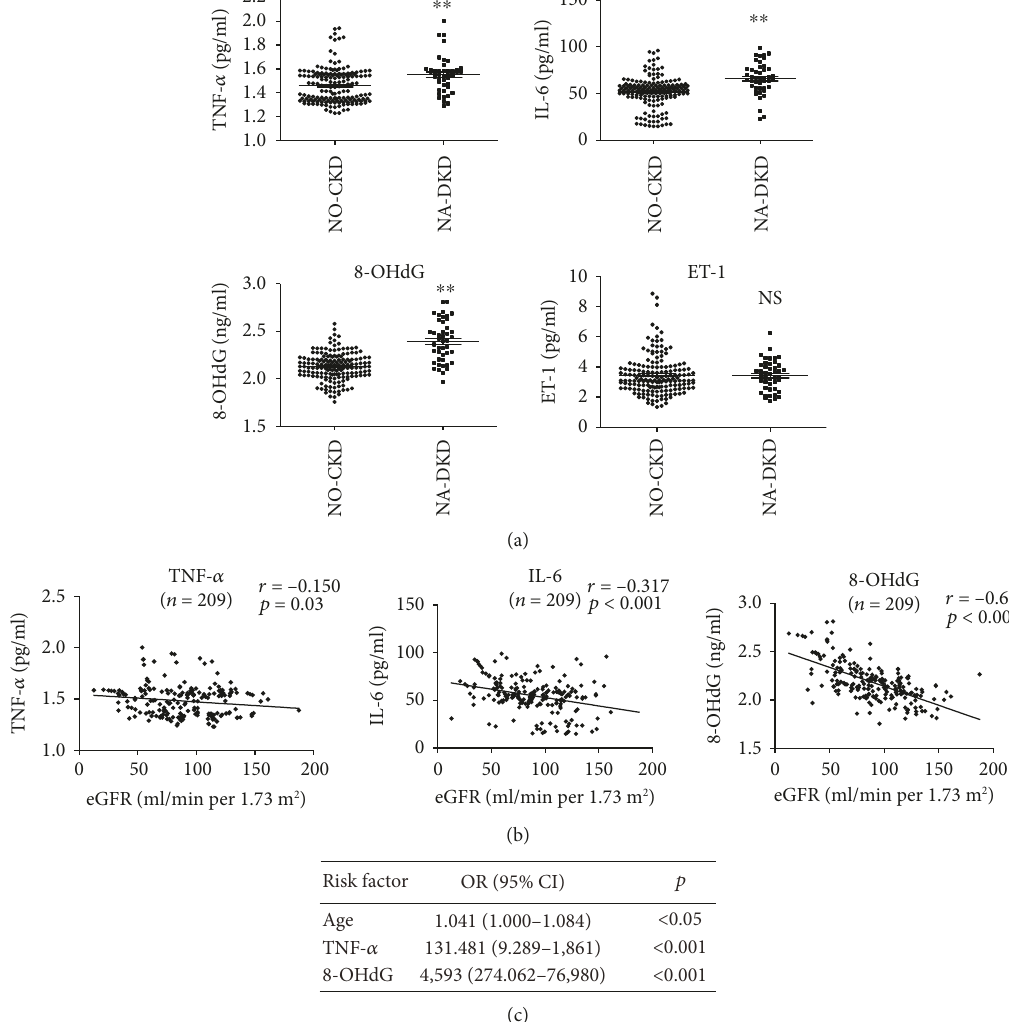
Figure 1: Correlations between plasma TNF- α , IL-6, 8-OHdG, and ET-1 with eGFR in T2DM patients with normoalbuminuria. (a) Di ff erences in the plasma TNF- α , IL-6, 8-OHdG, and ET-1 levels in patients with normoalbuminuria with/without renal insu ffi ciency. (b) Relationships of plasma TNF- α , IL-6, and 8-OHdG with the eGFR in T2DM patients with normoalbuminuria. (c) Logistic regression analyses between clinical parameters, plasma TNF- α , IL-6, and 8-OHdG and eGFR. 8-OHdG: 8-hydroxydeoxyguanosine; ET-1: endothelin-1; NO-CKD: normoalbuminuric T2DM patients without renal insu ffi ciency; NA-DKD: normoalbuminuric T2DM patients with renal insu ffi ciency; eGFR: estimated glomerular fi ltration rate. ∗∗ p < 0 01 vs. the NO-CKD group. NS: no signi fi